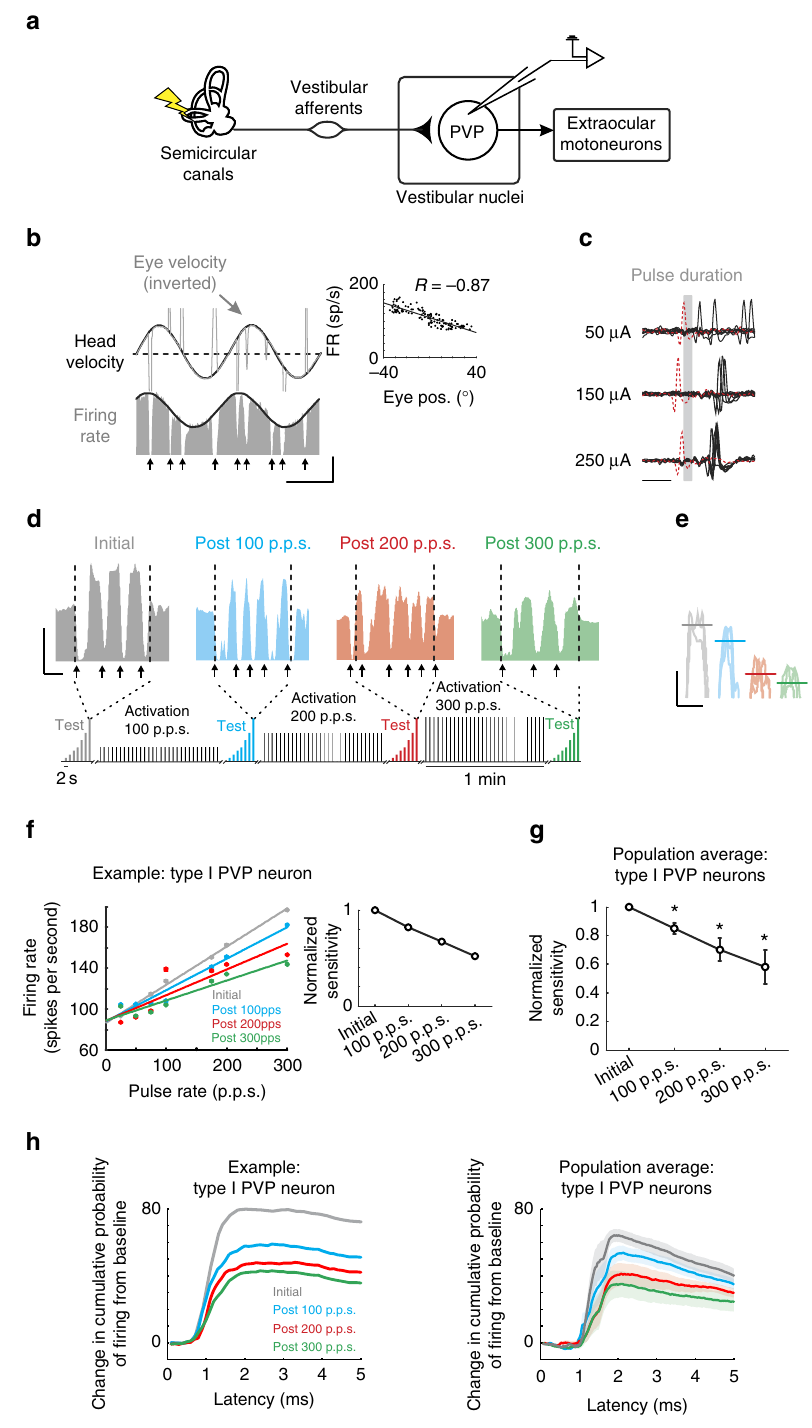
Figure 2 | Rapid plasticity within direct VOR pathways. ( a ) Diagram of direct VOR circuitry. ( b ) Firing rate of example type I PVP neuron during VOR. Note eye velocity is inverted and the ipsilateral direction relative to side of recording is upwards. Arrows highlight when saccades occurred. Inset shows example neuron’s eye position sensitivity. Calibrations bars, 40 (cid:2) per s, 100 spikes per s, 1s. ( c ) Same example neuron’s response to single pulses of increasing current amplitude. Red traces indicate trials during which the neuron failed to fire an action potential because the pulse occurred during its refractory period. Calibration bar, 1ms. ( d ) Firing rate before (grey) and after activation of the vestibular nerve with rates of 100 (blue), 200 (red) and 300p.p.s. (green) in response to test stimuli delivered at 300p.p.s. Note that following activation, the response of the neuron decreased. Inset shows schematic of electrical stimulation protocols. Arrows show when saccades occurred. Calibrations bars, 100 spikes per s, 0.25s ( e ) Periods of firing rate during the compensatory portion of the eye movement for the example neuron are superimposed to show the decreased response after activation of the vestibular nerve. Calibrations bars, 50 spikes per s, 0.25s. ( f ) Plot of firing rate as a function of pulse rate for example neuron before and after activation of the vestibular nerve. Inset shows normalized sensitivity (slope of firing rate versus pulse rate) for example neuron. ( g ) Population average of normalized sensitivity for type I PVP neurons ( n ¼ 15). * P o 0.05 (Student’s t -test). ( h ) Probability of firing as a function of latency following individual pulses for example neuron (left) and population averages (right) before and after activation of vestibular nerve. Error bars and shaded area represent ±